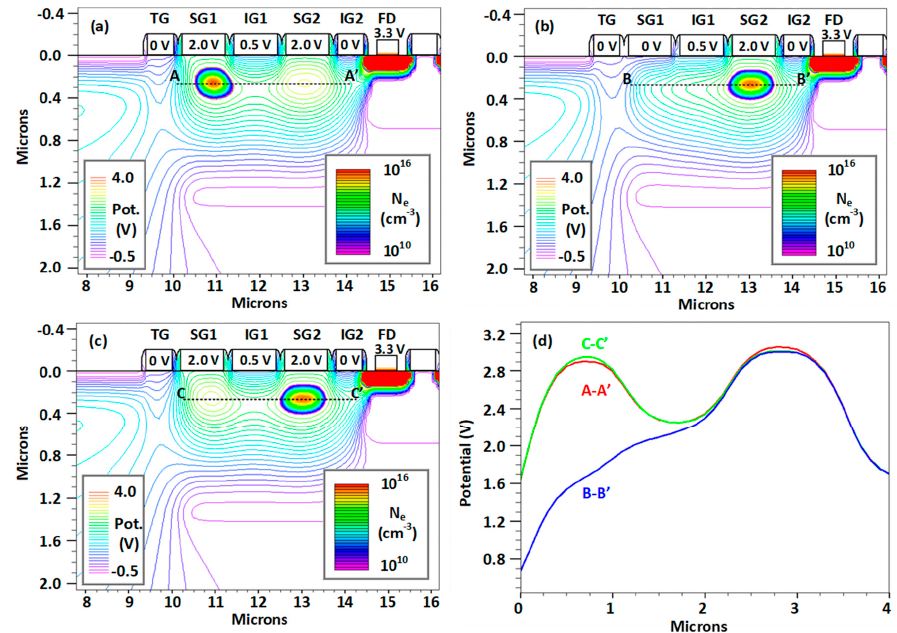
Figure 3. Simulated potential profile in the buried channel and electron density plots for the charge stored under SG1 ( a ), during transfer from SG1 to SG2 ( b ) and for the charge stored under SG2 ( c ). Plot ( d ) shows the potential along the dashed lines in (a), (b) and (c).